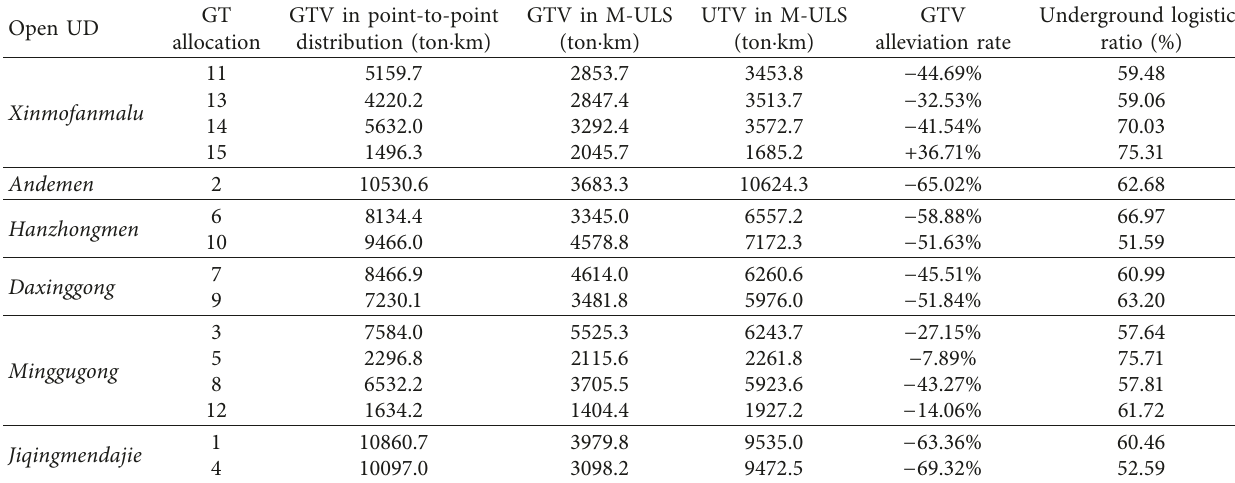
Table 3: Comparison of traffic volume between point-to-point mode and M-ULS.